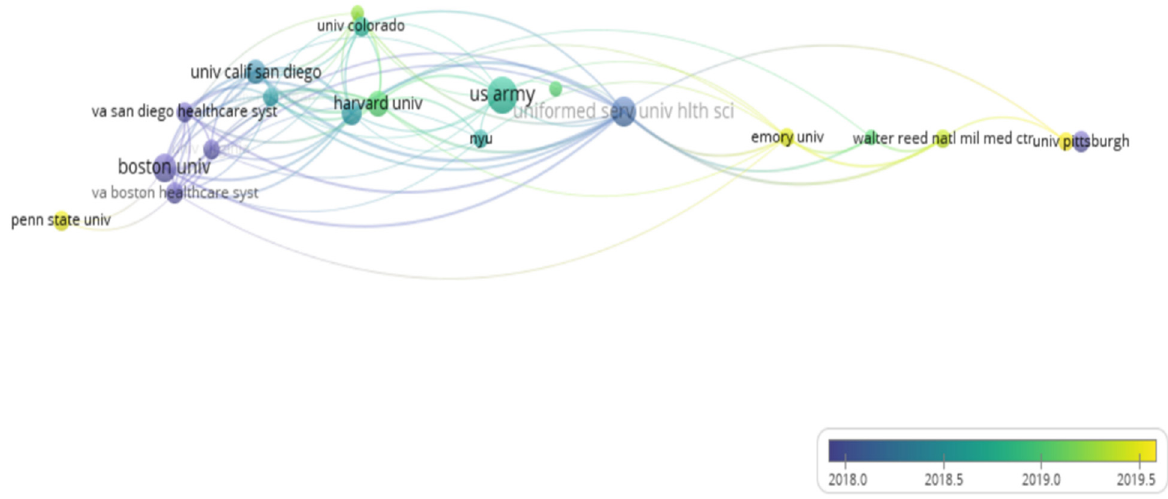
Figure 18. Network by co-authorship.